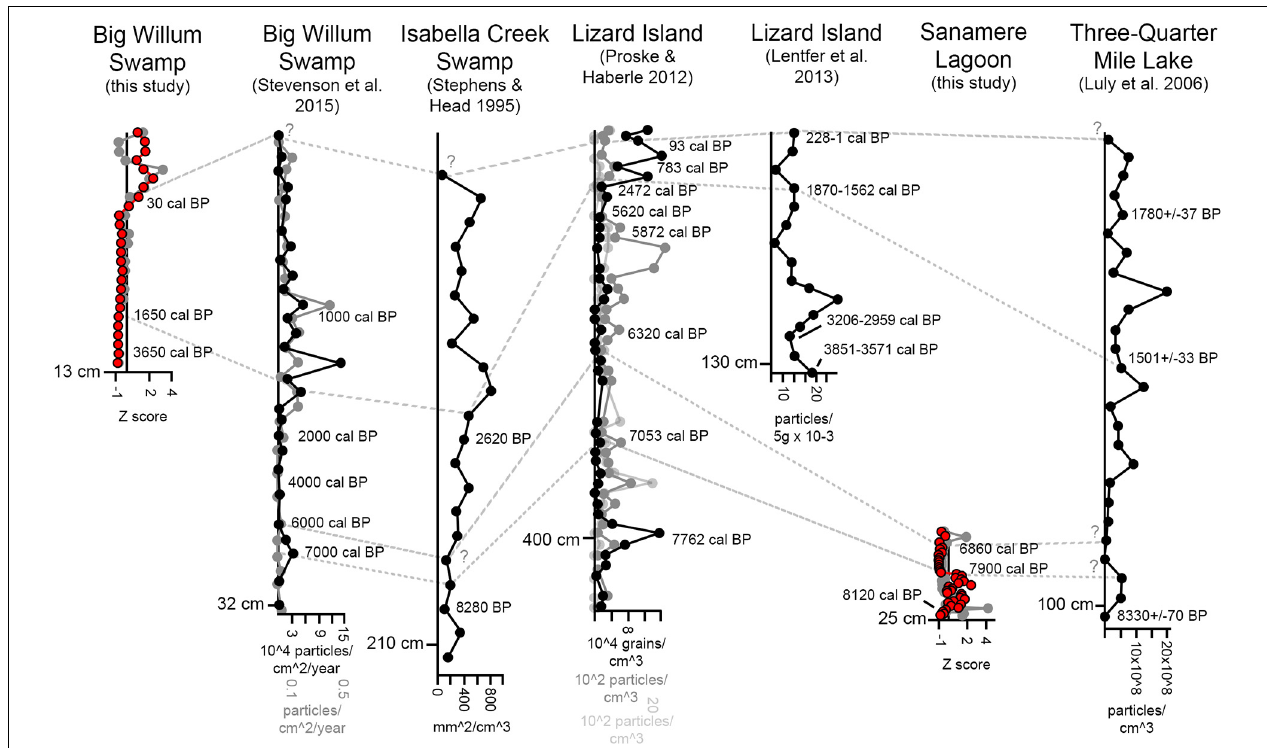
FIGURE 8 | Previously published charcoal records from mainland Cape York Peninsula (adapted from Luly et al., 2006; Proske and Haberle, 2012; Lentfer et al., 2013; Stevenson et al., 2015) and the Sanamere Lagoon and Big Willum Swamp records from this study. Black dots represent microscopic charcoal, gray dots represent macroscopic charcoal and red dots represent bulk pyrogenic carbon. Dashed lines indicate interpretable changes in the Sanamere Lagoon and Big Willum Swamp records and show their approximate correspondence with previously published records, with question marks indicating uncertain correspondence where dates are unavailable. Note that scales vary between records and all are plotted relative to depth. Length of Y axis is approximately scaled to maximum age for visual